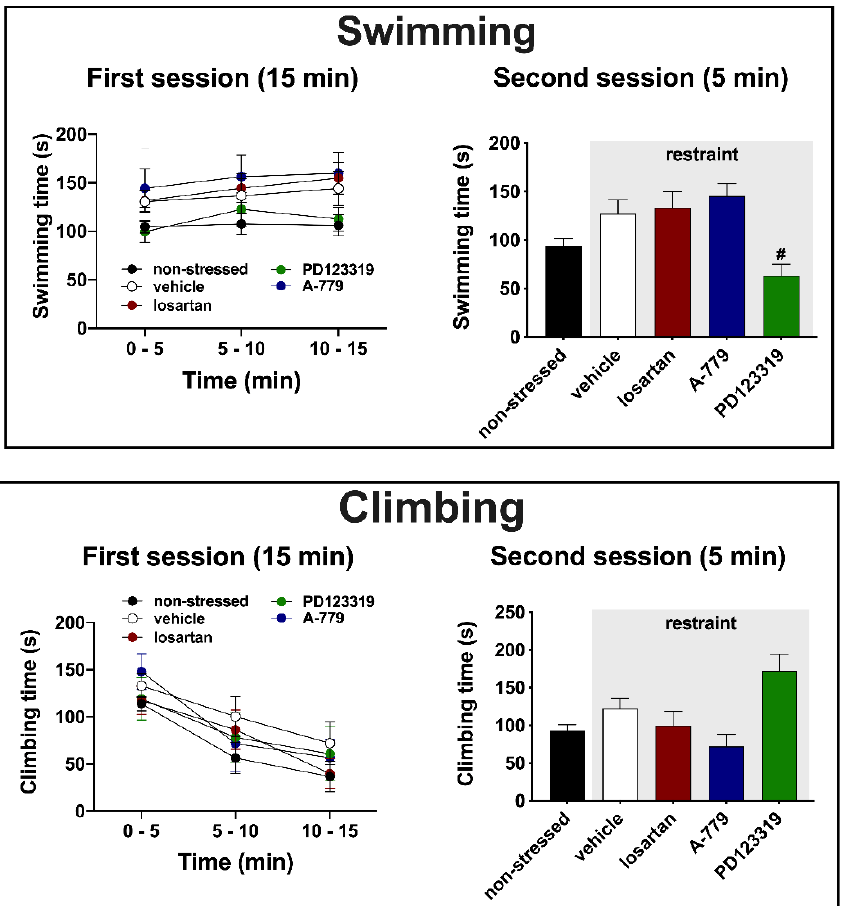
Figure 3. Swimming and climbing time in the forced swimming test (FST) of animals submitted to an acute session of restraint stress and that received bilateral microinjection in the medial amygdaloid nucleus (MeA) of the selective AT 1 receptor antagonist losartan (1 nmol/100 nL, n = 9), the selective MAS receptor antagonist A-779 (0.1 nmol/100 nL, n = 10), the selective AT 2 receptor antagonist PD123319 (5 nmol/100 nL, n = 8) or the vehicle (saline, 100 nL, n = 21); as well as animals who were not submitted to restraint stress (non-stressed, n = 15). ( Top ) Swimming time each 5 min during the pre-test session (first session, left ), which was performed immediately after the end of the acute restraint session, and during the entire test session (second session, right ) that occurred 24 h after the pre-test session of the FST. ( Bottom ) Climbing time each 5 min during the pre-test session (first session, left ), and during the entire test session (second session, right ). The bars represent the mean ± SEM. Results of the first session were analyzed using two-way ANOVA, whereas one-way ANOVA followed by Bonferroni post-hoc test was used in the results of the second session. # p < 0.05 vs. vehicle group (subjected to restraint stress).